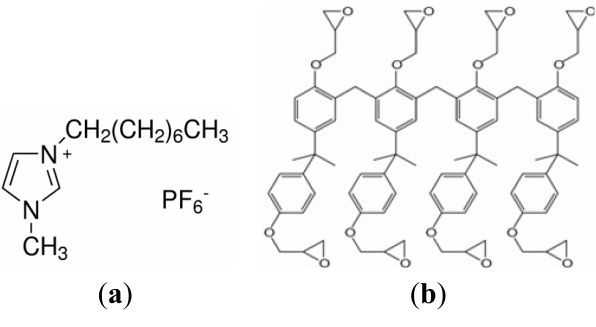
Figure 1. Schematics of ( a ) 1-Methyl-3-octylimidazolium hexafluorophosphate and ( b ) SU-8